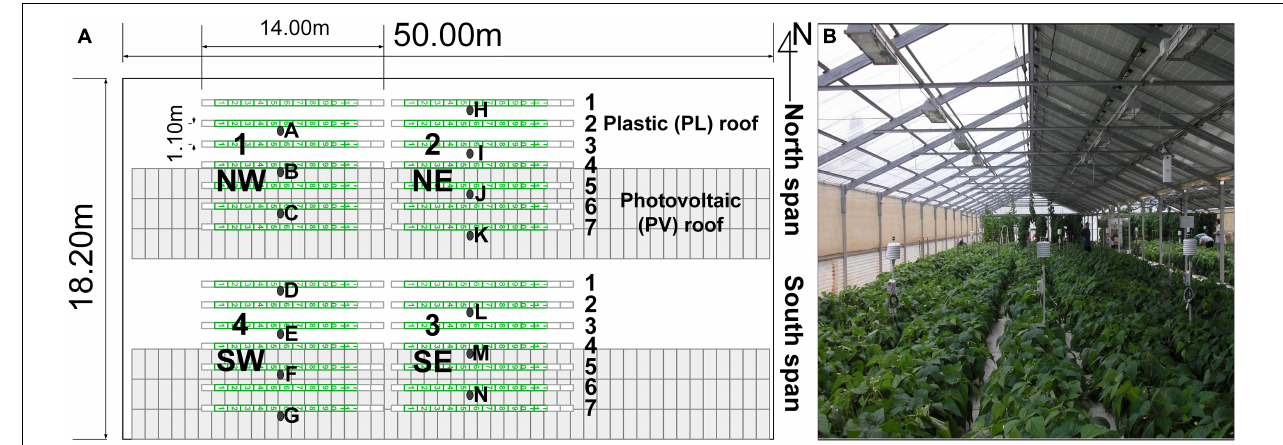
FIGURE 1 | Photovoltaic greenhouse map (A) , plants rows (green lines) and experimental areas with sensor stations (black dots) and dwarf green bean crop inside the greenhouse (B) . Station D [under the plastic (PL) roof] and N [under the photovoltaic (PV) roof] were provided with additional photoradiometers for photosynthetic active radiation (PAR). Other experimental trials were performed in the background of the picture.